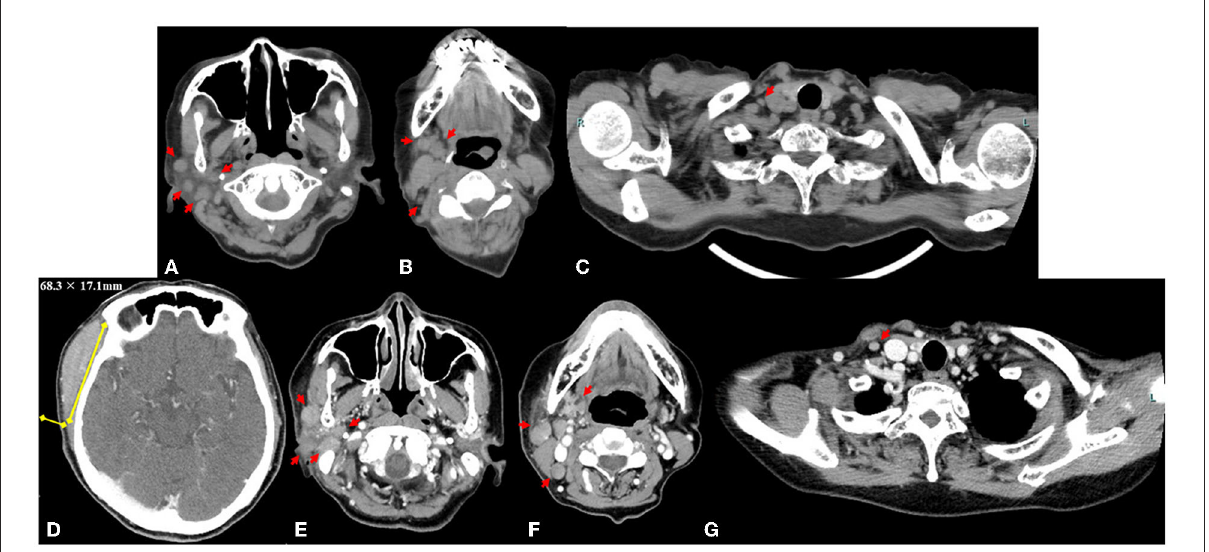
FIGURE3 Axial computed tomography image obtained at the first visit shows 14 lymphadenopathies, with a maximum diameter ≤ 7.5mm (red arrows) in the right parotid region (A) , submandibular and jugular regions (B) , and supraclavicular region (C) . Measurement of the right temporal mass (68.3 × 17.1mm) on an axial contrast-enhanced computed tomography image 9 weeks after the first visit to our institution (D) . The lymphadenopathies (maximum size ≤ 13.3mm, yellow arrows) in the right parotid region (E) , submandibular and jugular region (F) , and supraclavicular region (G) .